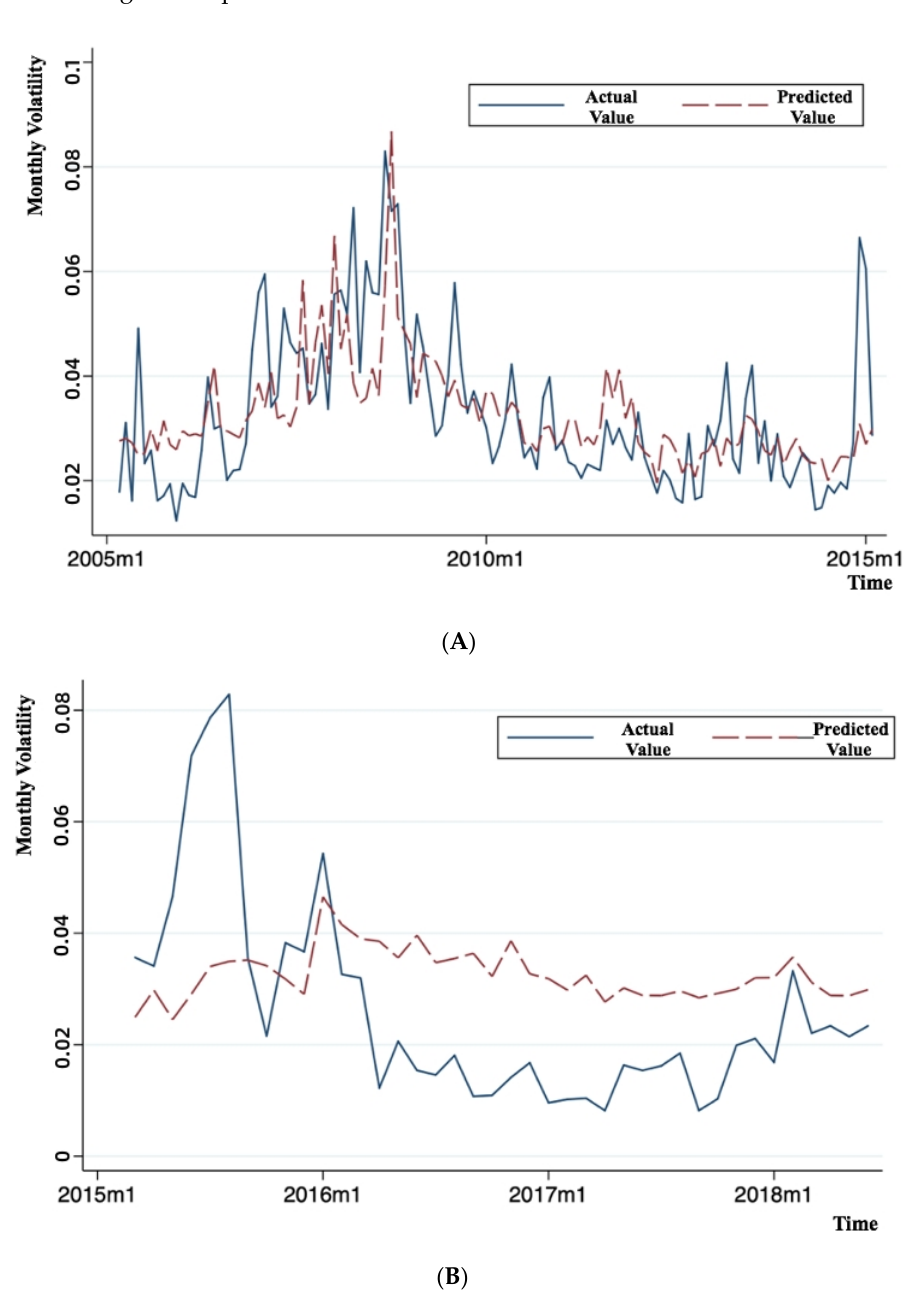
Figure 4. The predicted and actual monthly volatility: principal component analysis. Panel ( A ) presents the predicted and actual monthly volatility of the SSE 50 index before introducing the index options and Panel ( B ) presents the predicted and actual monthly volatility of the SSE 50 index after introducing the index options.